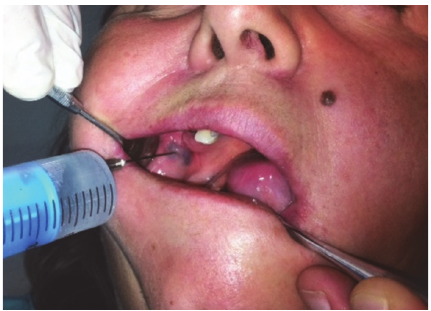
Figure 1: Submucosal hemangioma of the cheek at the right molar region.